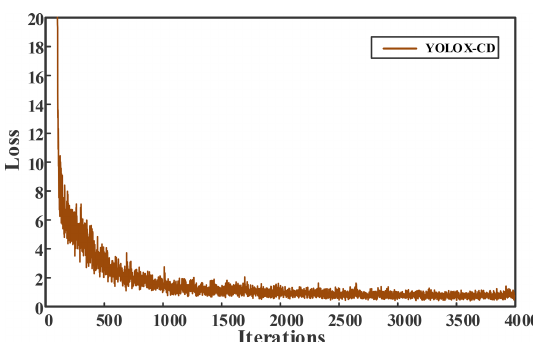
Figure 10. Loss function value change curve of YOLOX-CD.